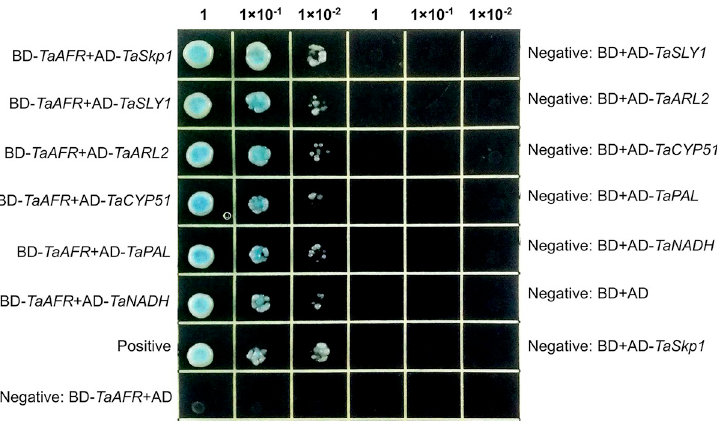
Fig 7. Protein interactions tested by Y2H assay. Yeast was cultivated on SD-WLHA+X- α -Gal plates for 3–5 days.